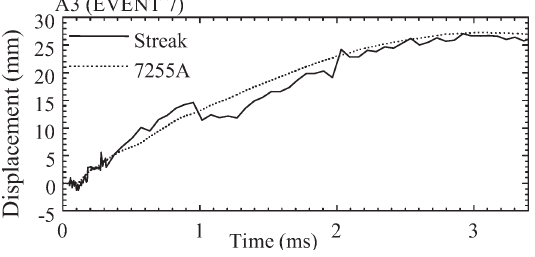
Fig. 13. Comparison, at the 10 cm stand-off distance, Event 7, be- tween streak photography and displacement derived from the 7255A